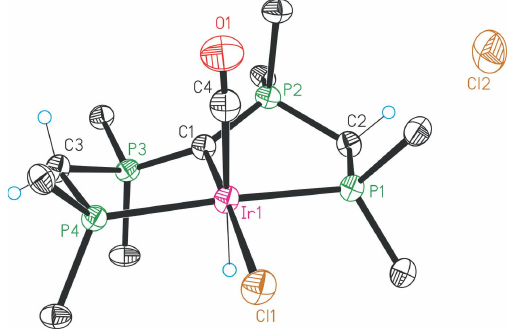
Figure 3 Structure of compound 3 , with atom labelling and 30% probability displacement ellipsoids. For clarity, only the ipso carbon atoms of the phenyl groups are shown, and the solvent molecules have been omitted.